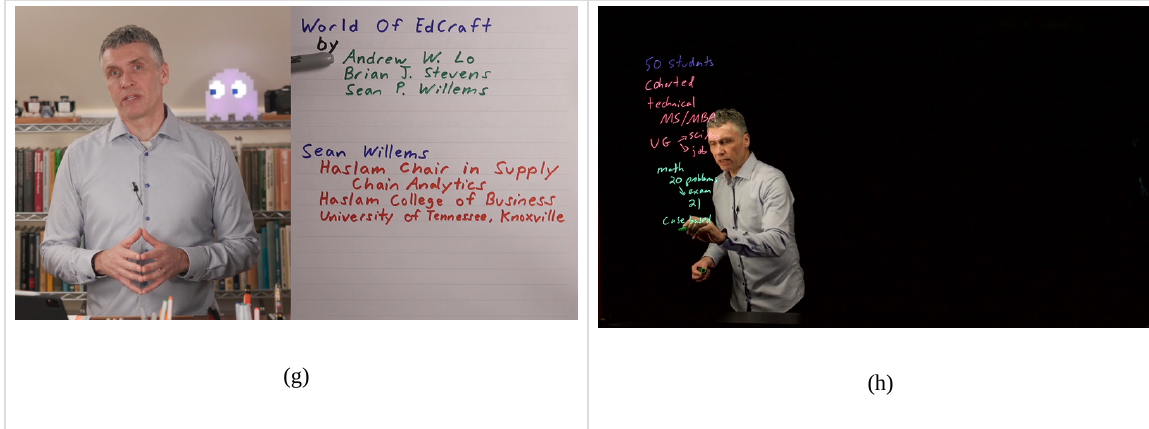
Figure 8. Three different online teaching formats used by Andrew Lo (a and b), Brian Stevens (c and d), and Sean Willems (e–